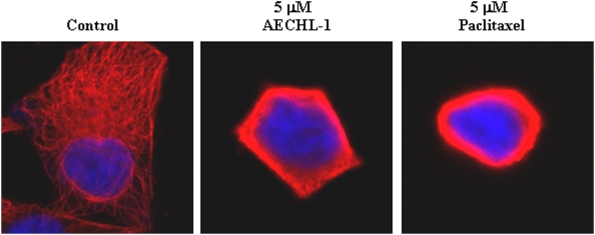
Effect of AECHL-1 on microtubules.MCF-7 cells were treated with the vehicle as a control, AECHL-1 (5
µM) and paclitaxel (5 µM) as a positive control for
24 h, and microtubules (red) were visualized by indirect
immunofluorescence. DAPI was used to stain the cell nuclei (blue).
Representative of 25–30 cells each in 3 separate
experiments.